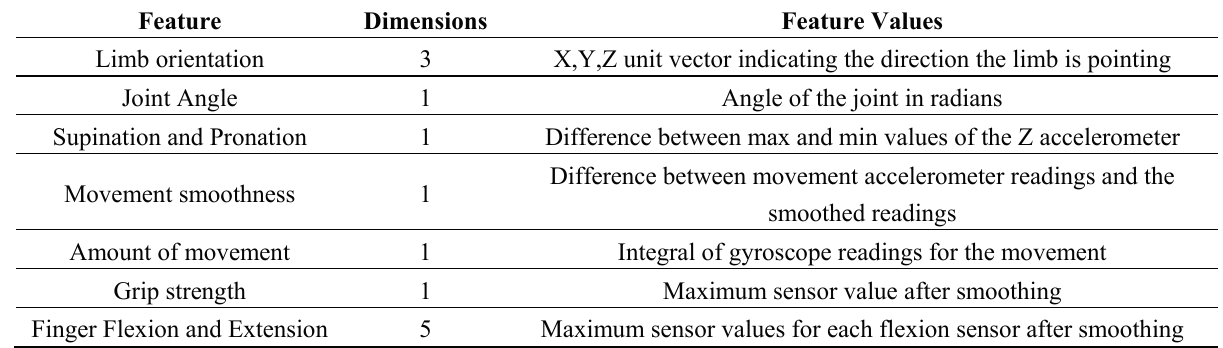
Table 1. An outline of the feature extraction routines implemented to analyze upper limb movement.